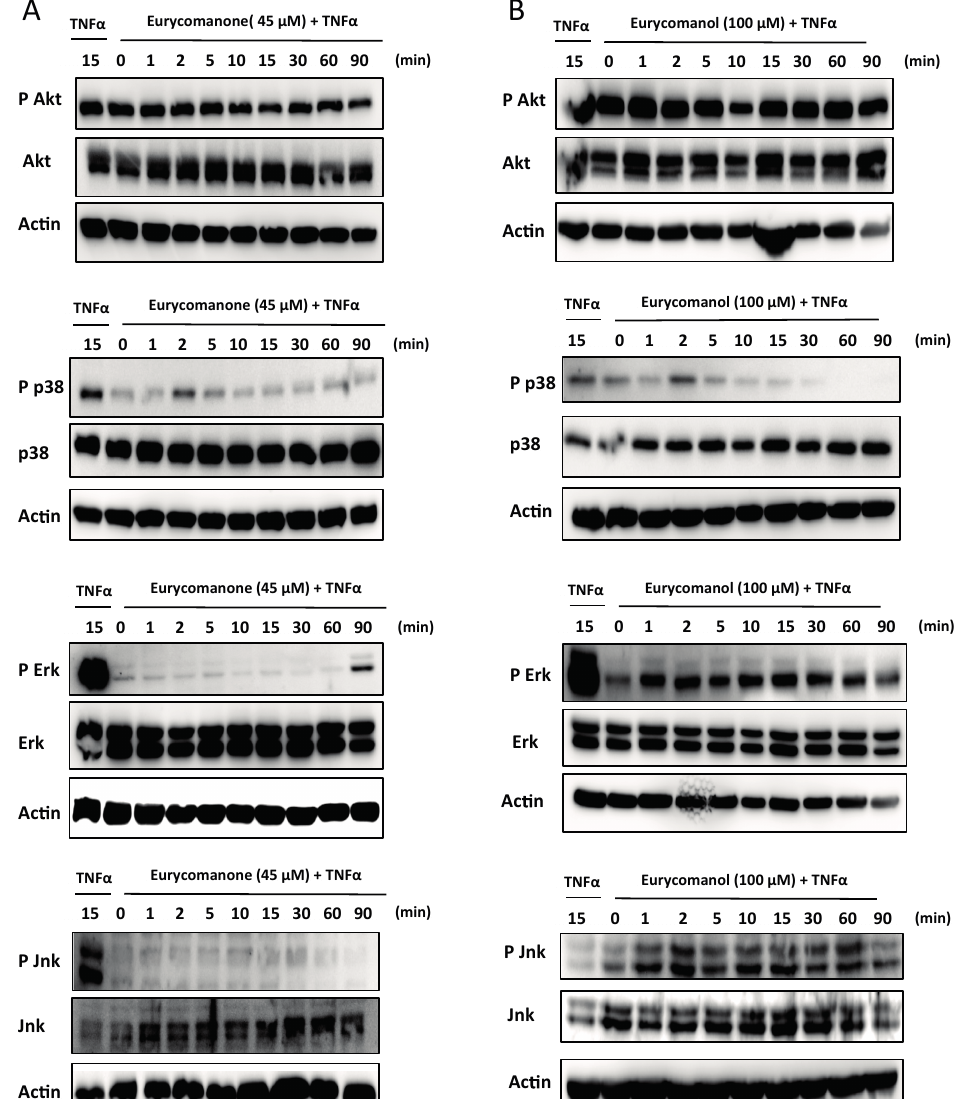
Figure 9. The effect of eurycomanone and eurycomanol on the activation of the MAPK and PI3K/Akt pathways. Jurkat cells were pre-treated with eurycomanone (45 μ M) ( A ) and eurycomanol (100 μ M) ( B ) for two hours followed by activation with TNF α (20 ng/mL) for the indicated time periods. Data are representative of three independent